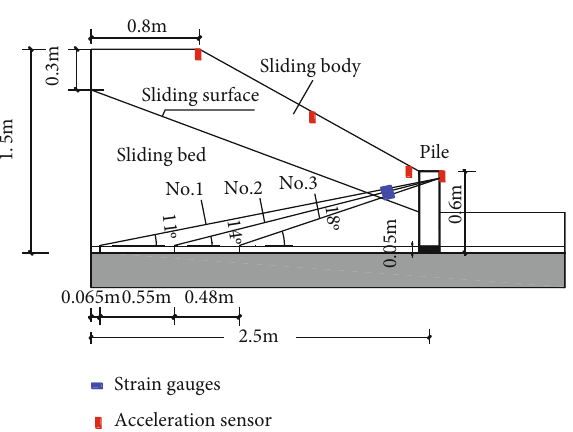
Figure 2: Schematic of the physical model.